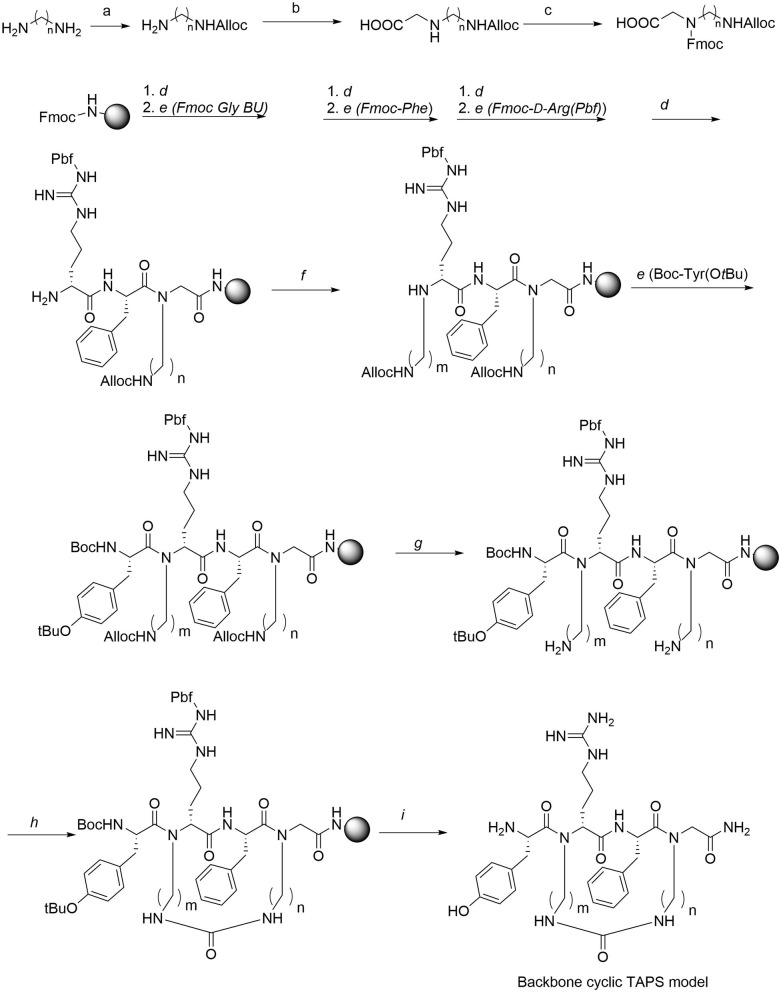
Synthesis of Gly-BU and TAPS c(n-m) backbone-cyclic peptide library. Reagents and conditions. a. Alloc-Cl, DCM. b. Glyoxylic acid, Sodium cyanoborohydride. c. Fmoc-OSu, Et3N. d. 20% piperidine/DMF. e. AA, HATU, DIPEA, DMF. f. Alloc-aminoalkyl aldehyde, NMP/MeOH, NaCNBH3. g. Pd(PPh3)4, PhSiH, DCM. h. BTC, DIPEA, DCM. i. TFA/TDW/TIS.